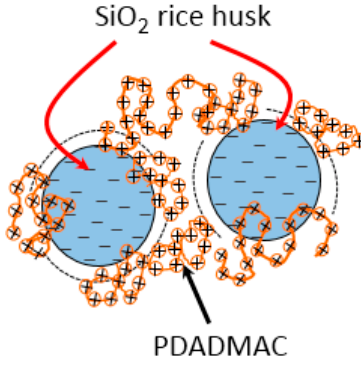
Figure 11. Cartoon representation of PDADMAC adsorption onto nanosilica rice husk.